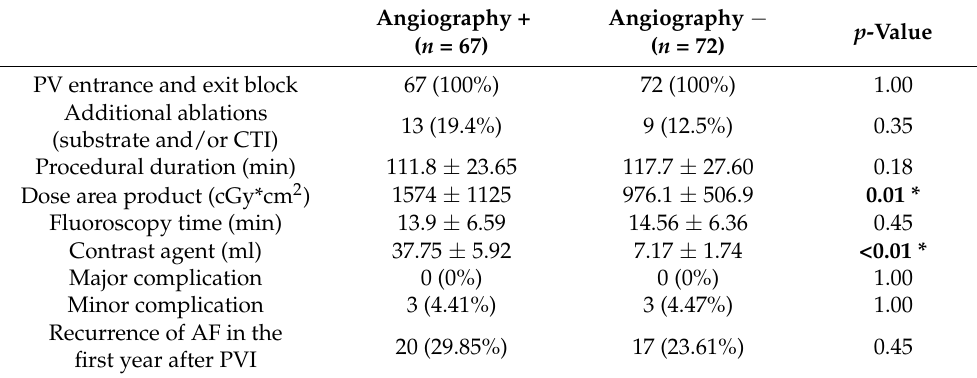
Table 2. Procedural parameters and clinical outcome of pulmonary vein